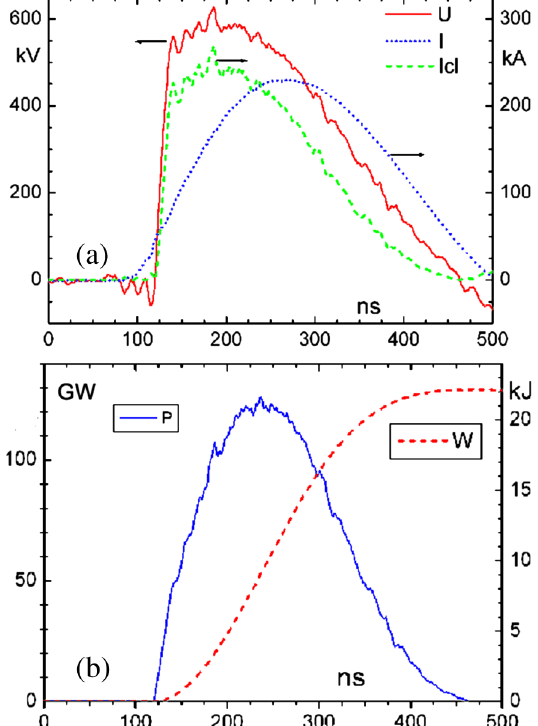
windows of a laser cell; 8—laser cell. 2